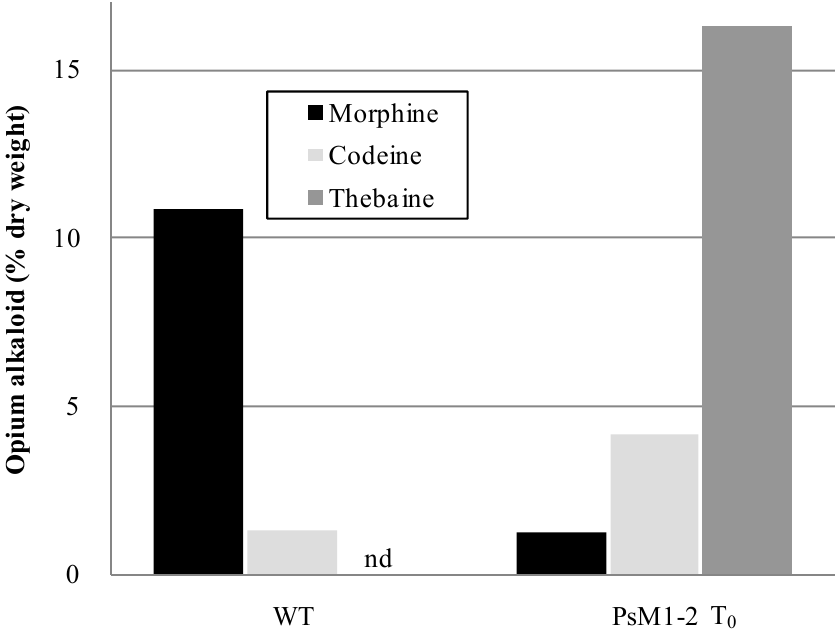
Figure 2. Alkaloid content in the latex from the soil-cultivated WT and PsM1-2 T nd: Not